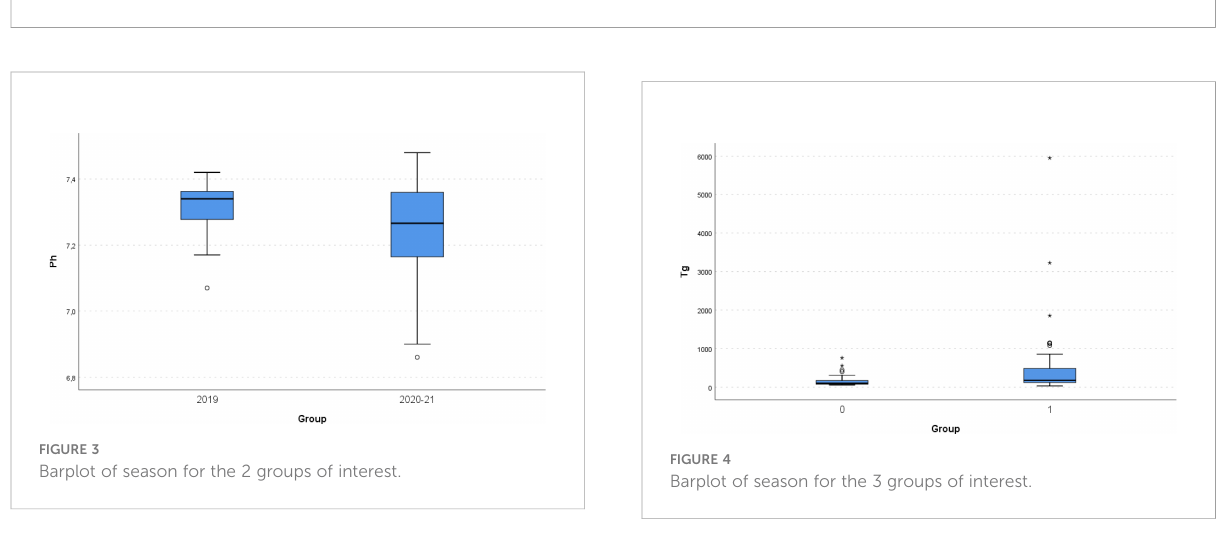
FIGURE 2 Boxplot of Tg (triglycerides) for the 2 groups of interest. P-value: 0,032. Values with a circle denote outliers, while values with an asterisk denote extreme outliers.